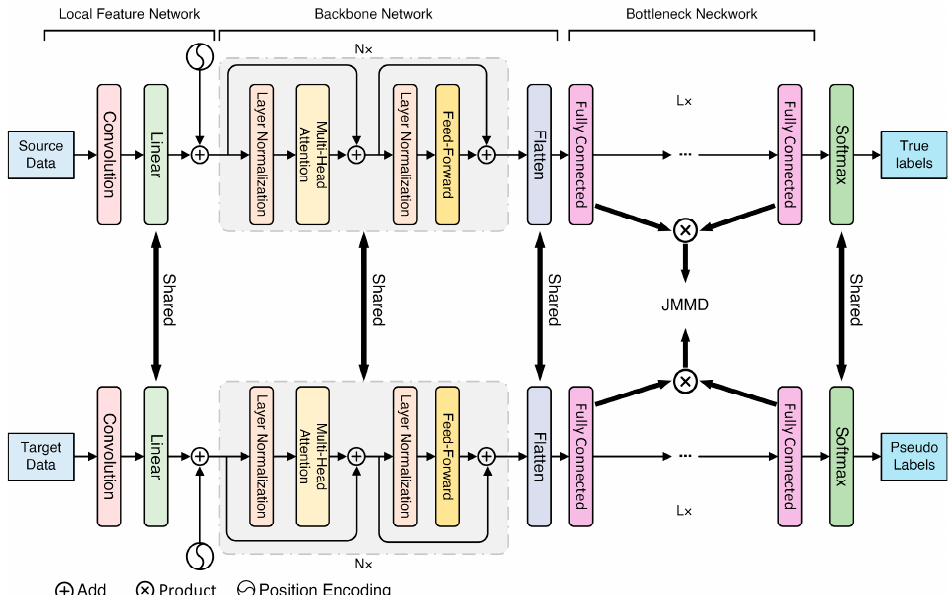
Figure 2. Structure of the proposed model.